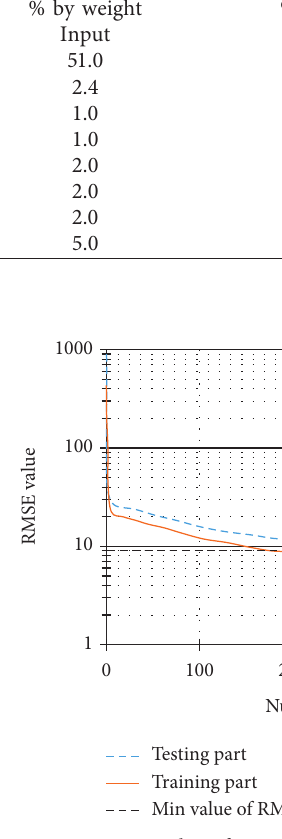
Figure 3: RMSE value of training part and testing part in function of number of